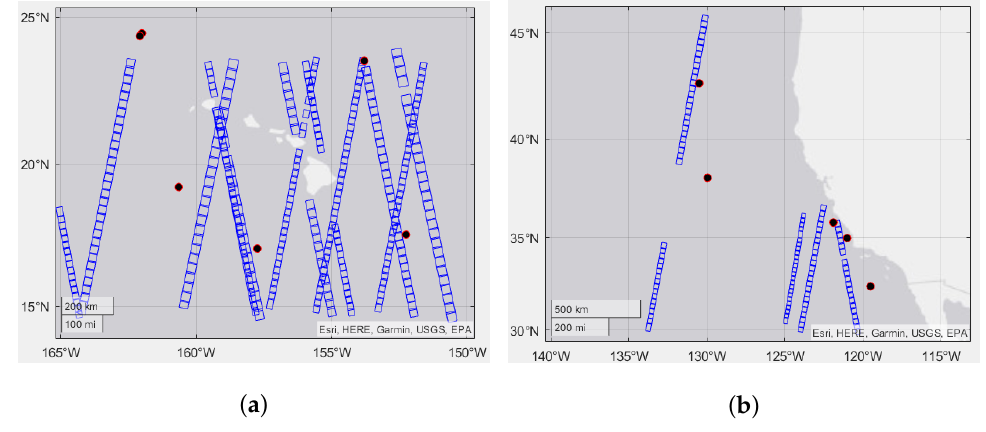
Figure 8. The map of SAR data location (Blue boxes) and buoy location of NDBC (black dots) of ( a ) the waters off the Hawaiian Islands and ( b ) the waters off the west coast of the United States. The NDBC buoy stations are 51000, 51001, 51002, 51003, 51004, 51101, 46002, 46011, 46028, 46047 and